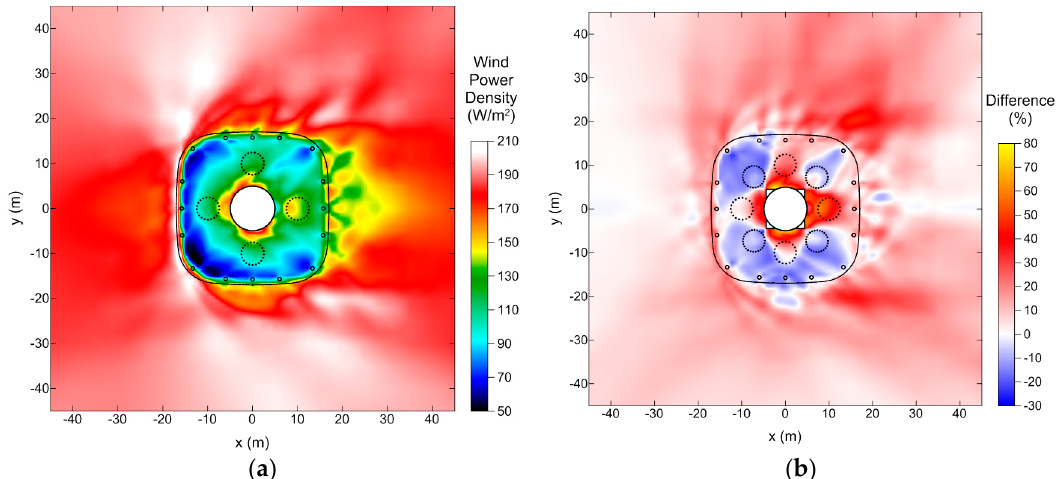
Figure 19. Wind resource map at 2 m above the Lotte World Tower roof (dimensions in meters): ( a ) wind power density map for circular cone structure; and ( b ) difference map of wind power density between the square and the circular cone cases.